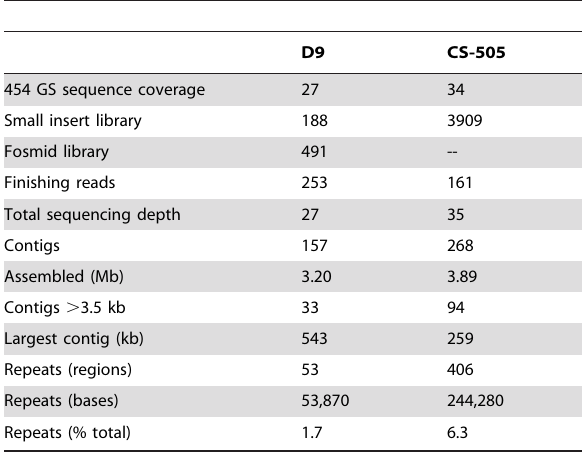
Table 1. Sequencing and assembly statistics for the two